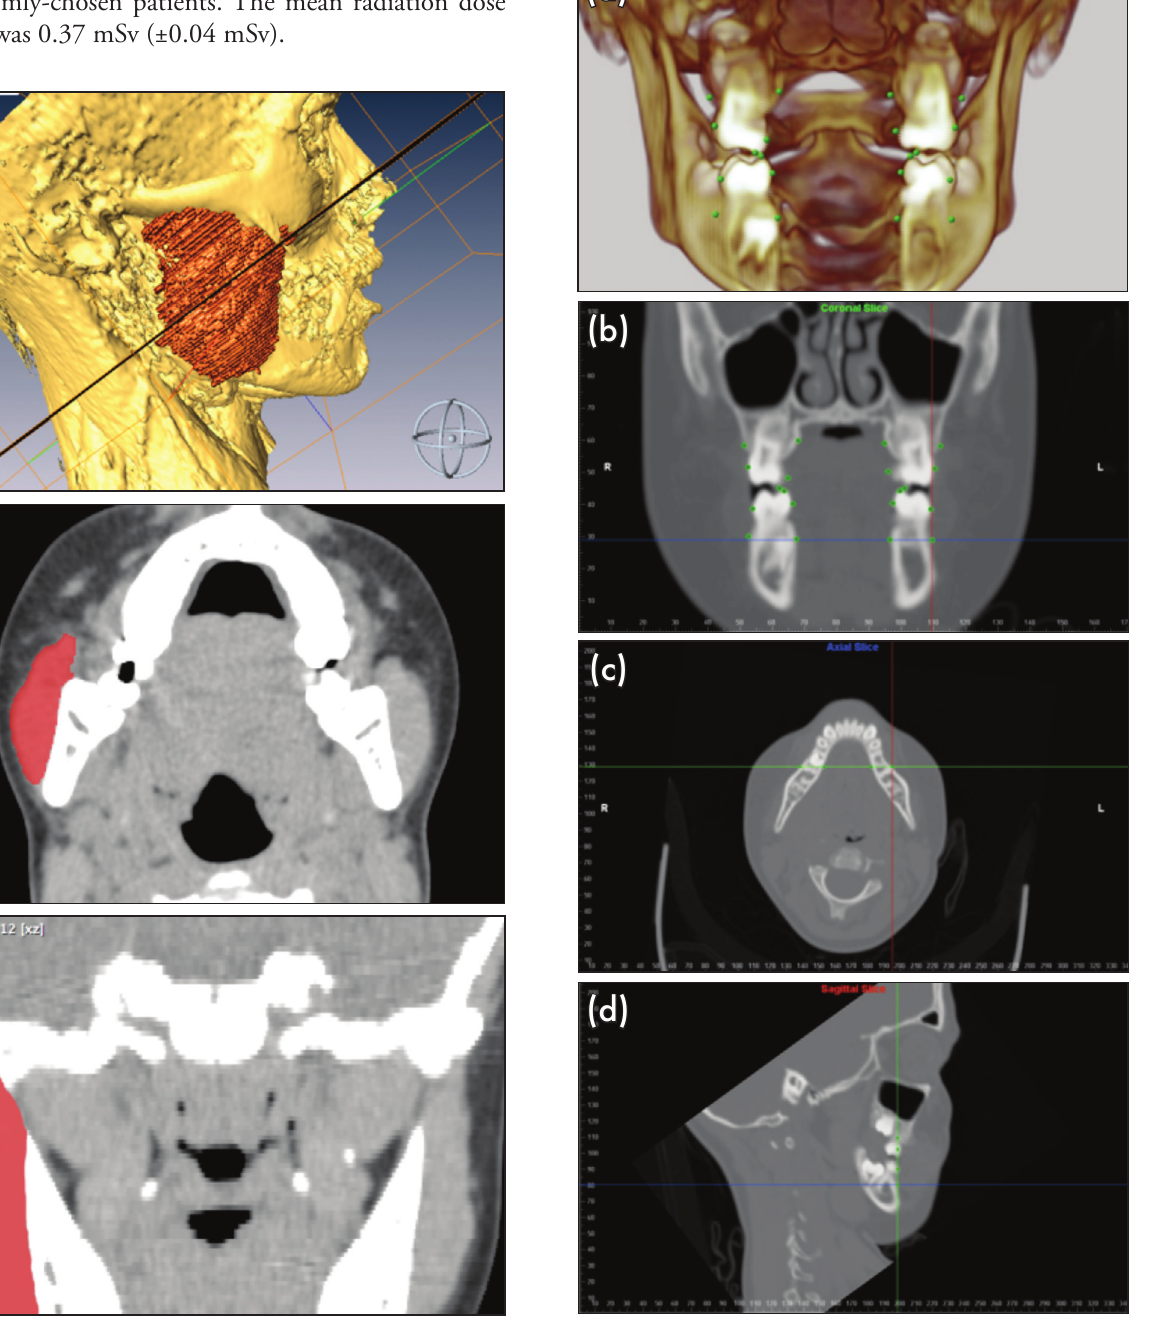
Figure 5. Maxillary and mandibular dental-arch width measurements. The relevant points were plotted on the 3D reconstruction (a), then verified by assessing the coronal (b), axial (c) and sagittal (d)